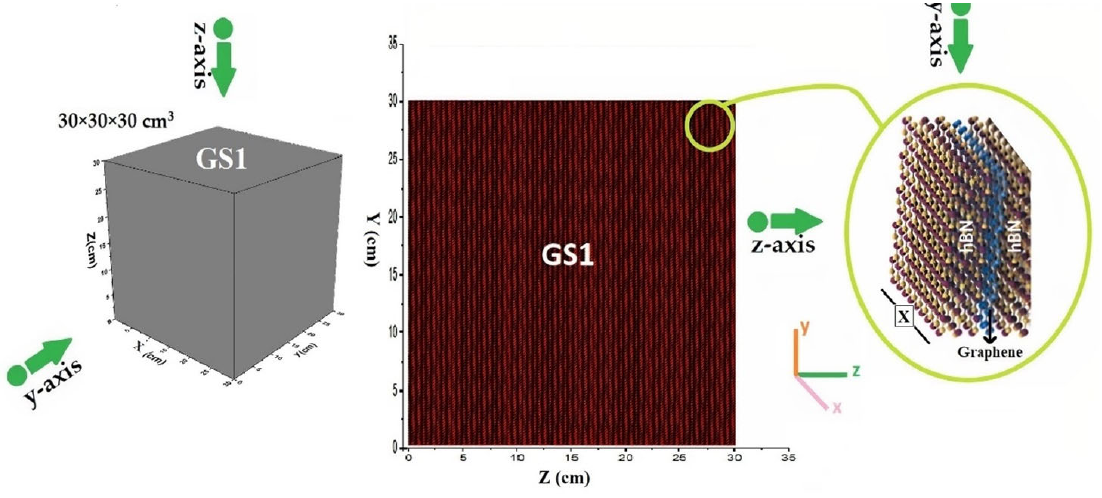
Figure 1. A geometric structure of metamaterial with periodic Macrobody surfaces structures with cubic lattice (GS1) obtained by MCNPX code.